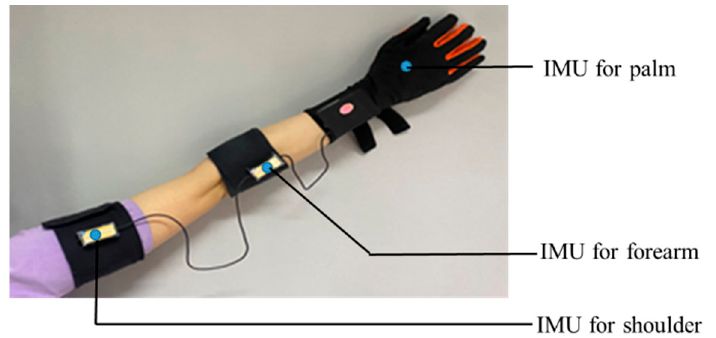
Figure 1. Sensor installation location.